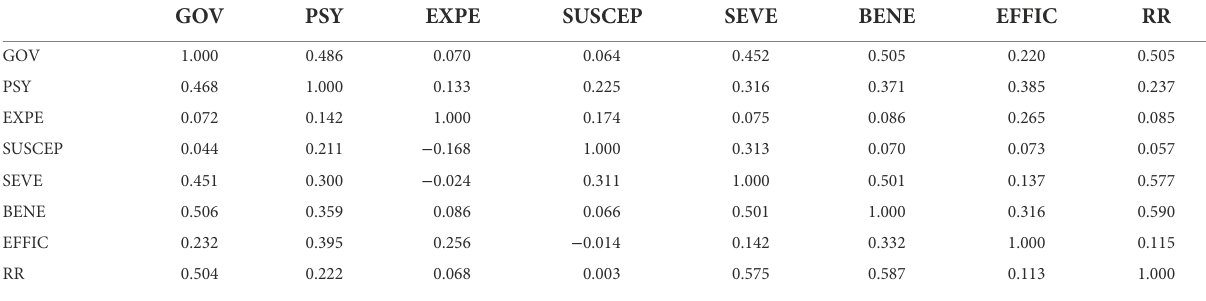
TABLE 3 Correlations and heterotrait–monotrait